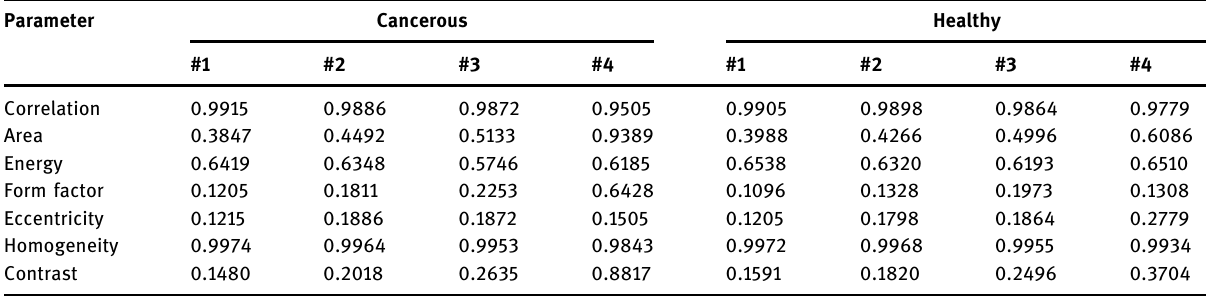
Table 4: Some signi fi cant example features for both cancerous and healthy images